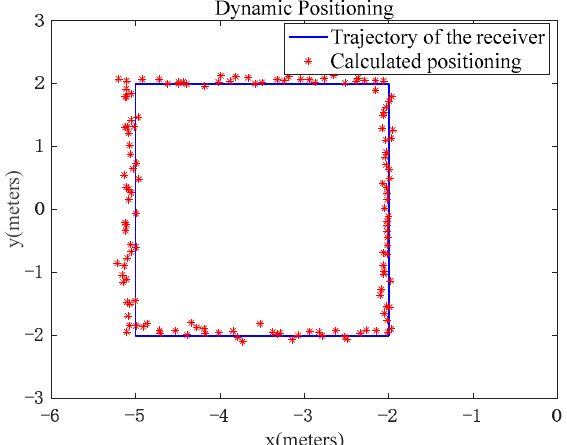
Figure 16. Dynamic positioning test of rectangular trajectory.